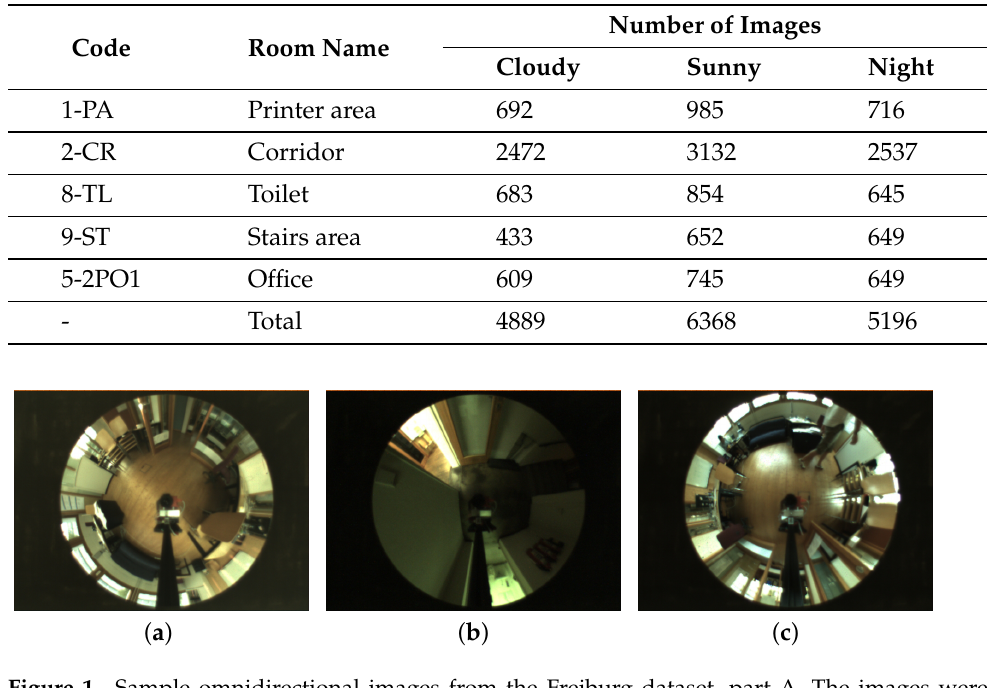
Figure 1. Sample omnidirectional images from the Freiburg dataset, part A. The images were captured under ( a ) cloudy, ( b ) night and ( c ) sunny illumination